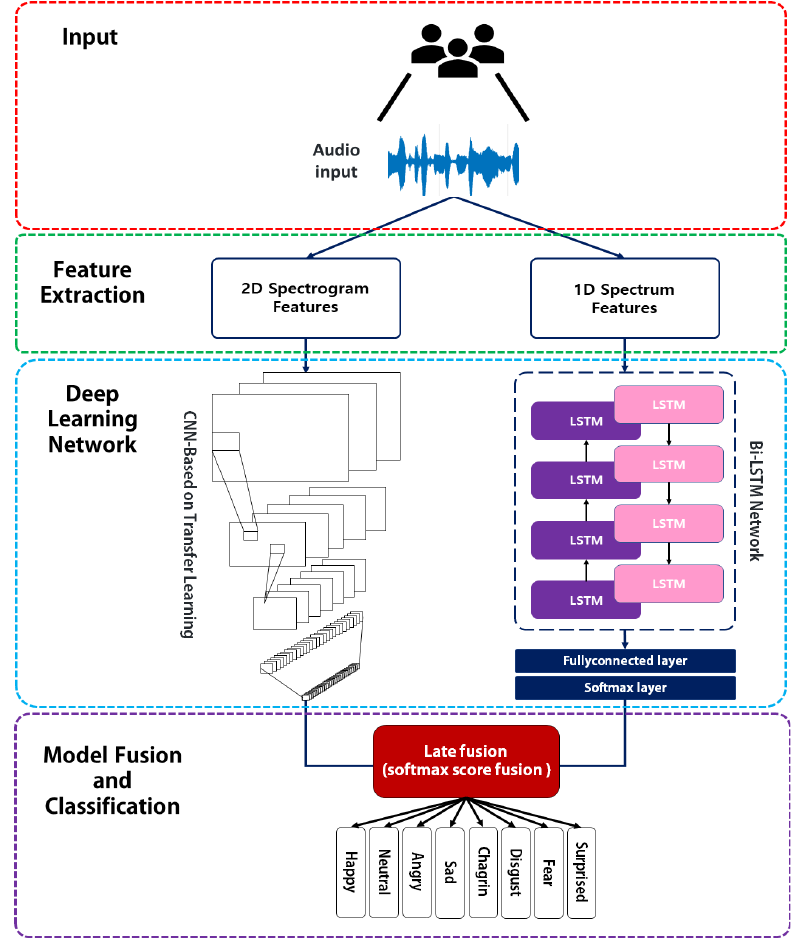
Figure 6. Structure of the Bi-LSTM and CNN two-stream-based SER model. The Bi-LSTM network used for 1D-spectrum learning used four Bi-LSTM layers, and each layer had 100, 100, 50, and 30 hidden layers. In addition, the dropout layers (with probabilities of 0.5, 0.5, 0.3, and 0.3) were added in between to prevent